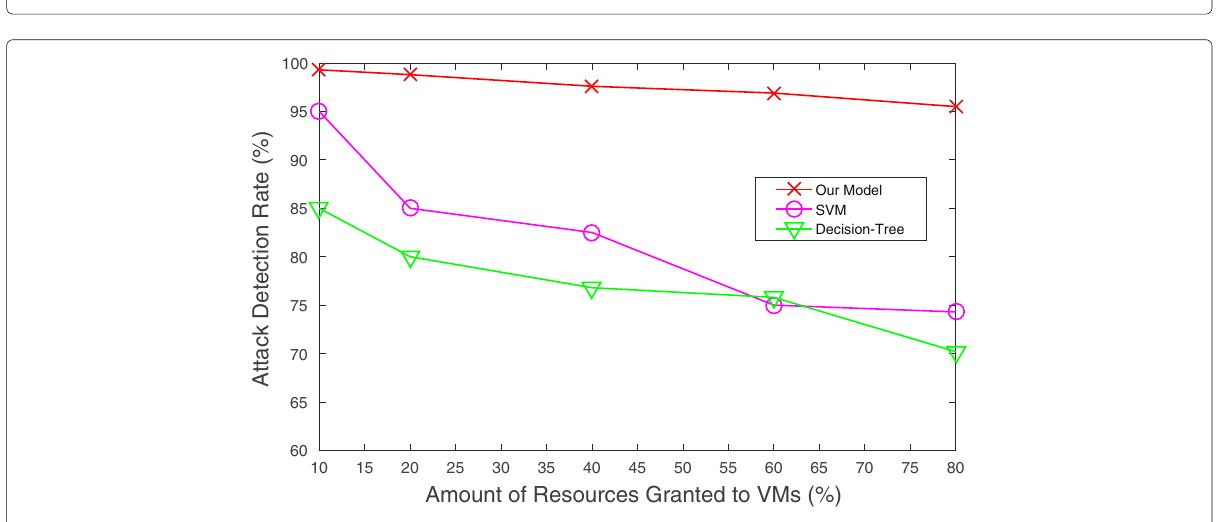
Fig. 9 Attack detection rate w.r.t. amount of granted resources